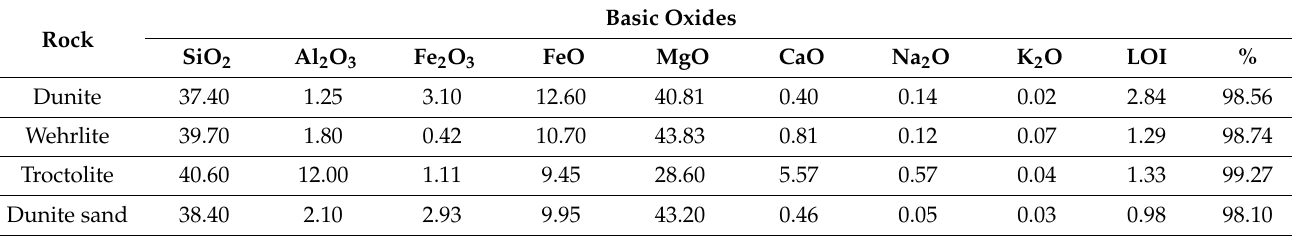
Table 1. Chemical composition of magnesium–silicate rocks, wt